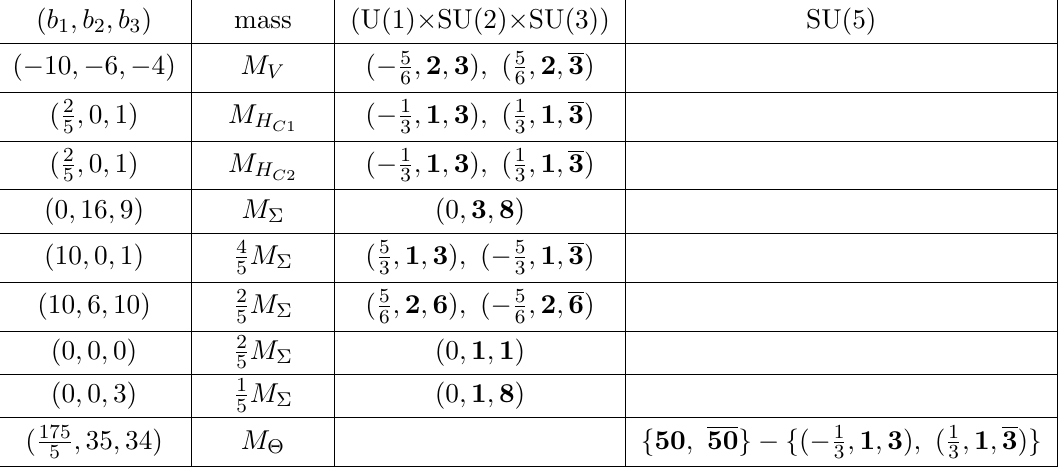
Table 3 . The GUT mass spectrum and the contribution to the (cid:12) -function coe(cid:14)cients. The second term of the Higgs superpotential eq. (4.1) is given